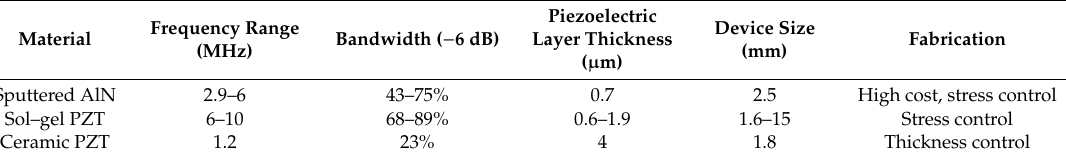
Table 5. Key findings of flexural vibration mode (FVM) pMUTs for endoscopic PAI applications.